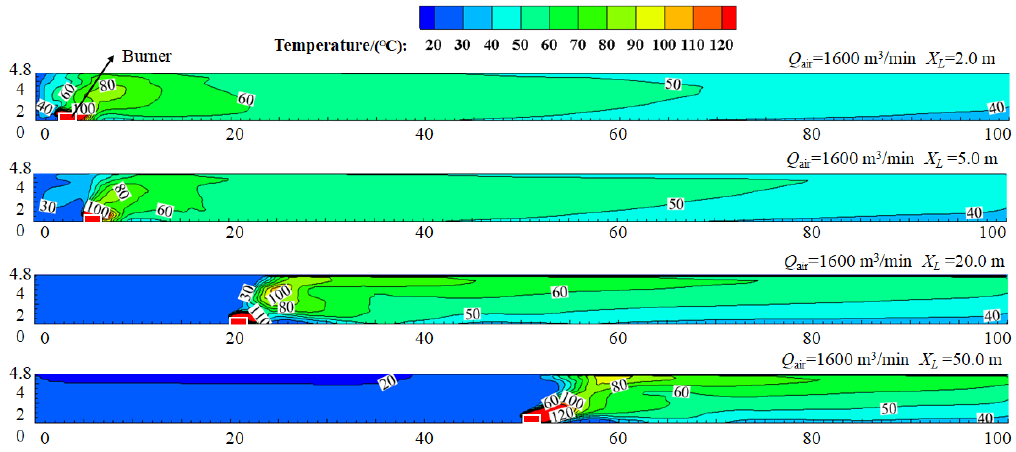
Figure 9. Longitudinal temperature distribution of the single-end tunnel under different fire locations.